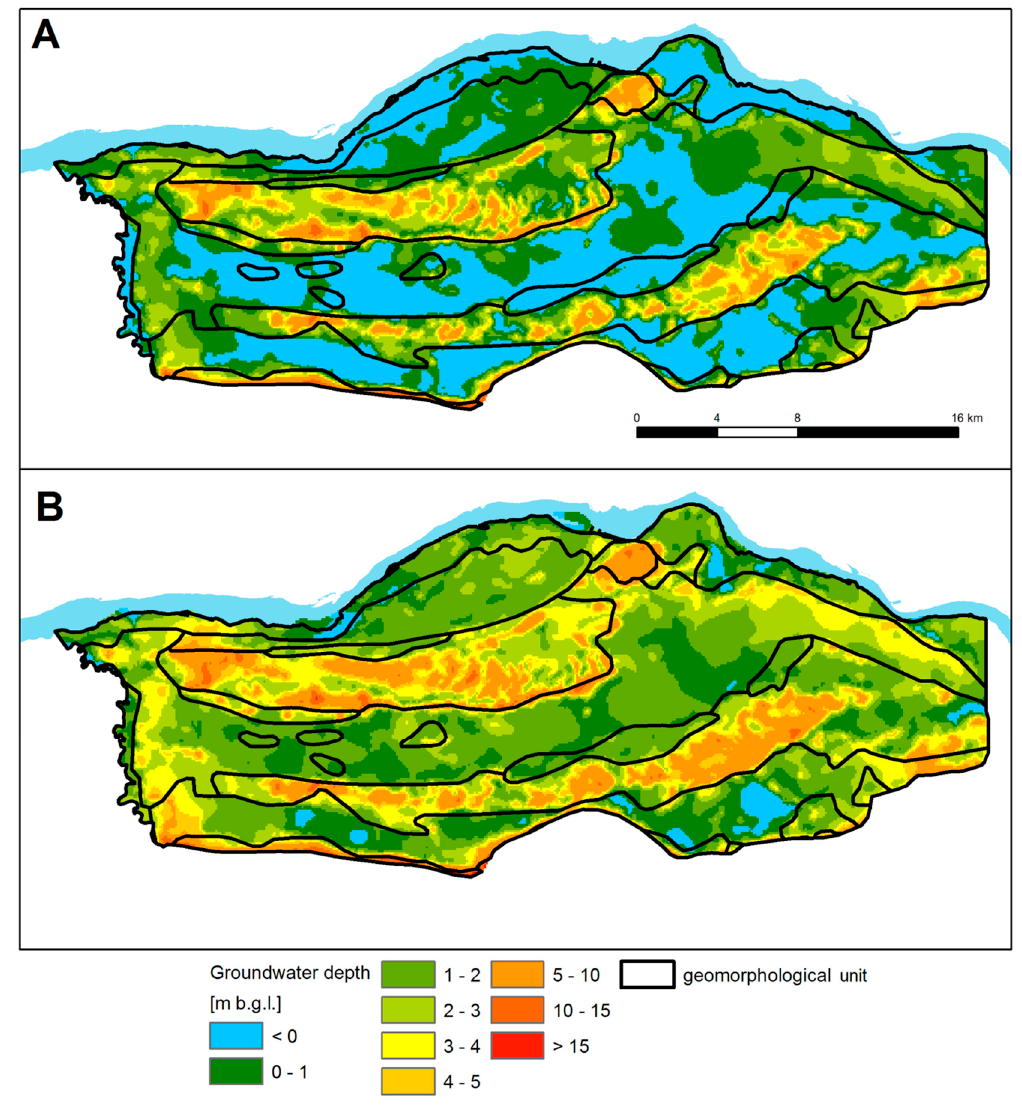
Figure 8. Groundwater depth in: A : variant 2; B : variant 3.